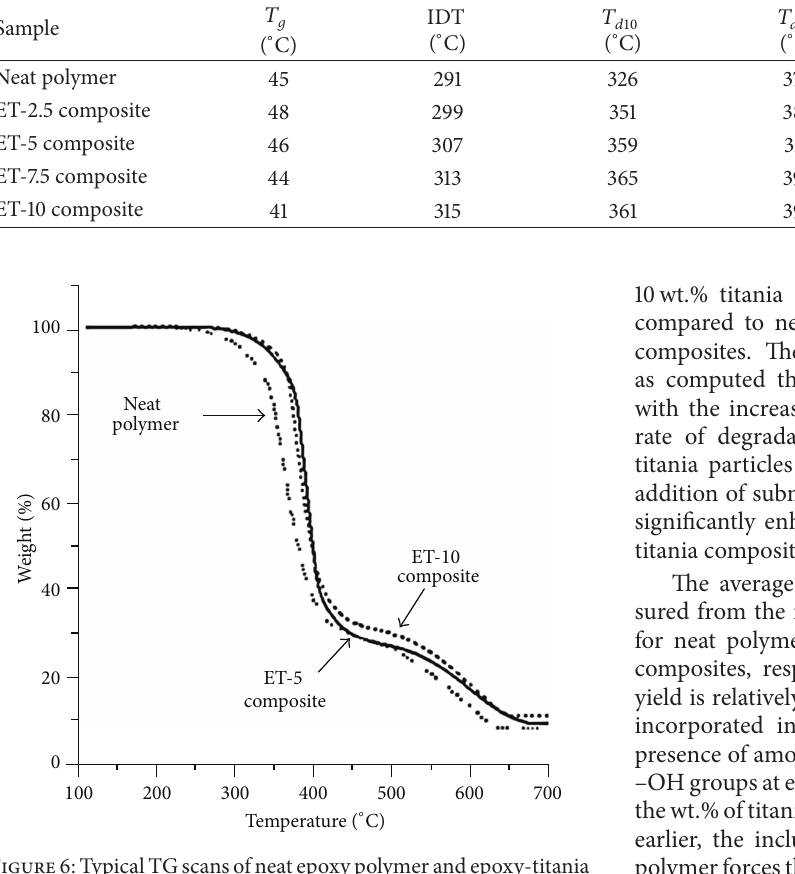
Figure6:TypicalTGscansofneatepoxypolymerandepoxy-titania composites with different concentrations of submicron titania par-